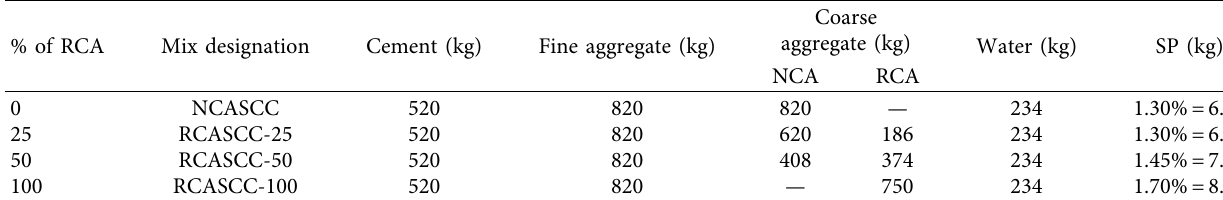
Table 4: Mix proportions of 1 m 3 of SCC